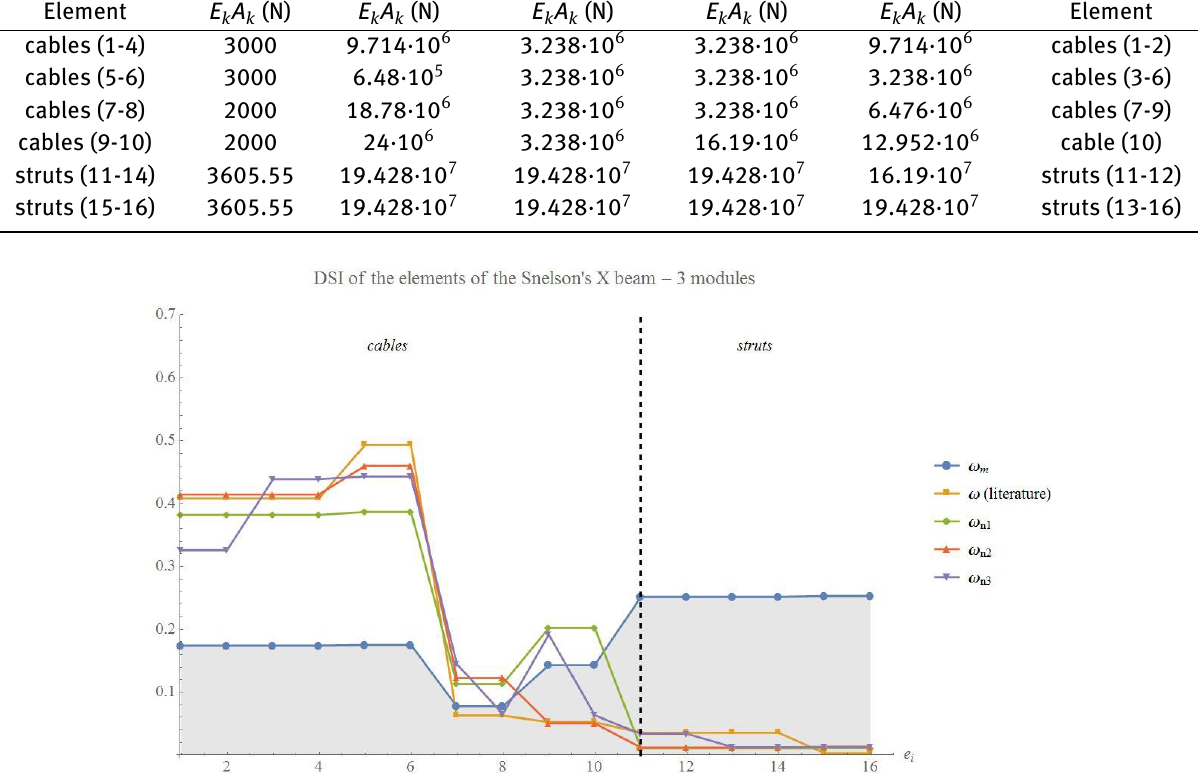
Figure 6: DSI of the elements of the Snelson’s X beam with three modules for different assignments of the axial stiffness